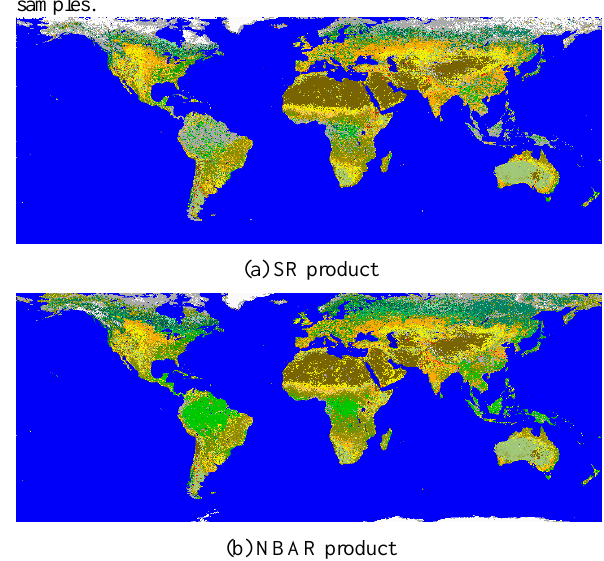
Figure 11. Land cover classification